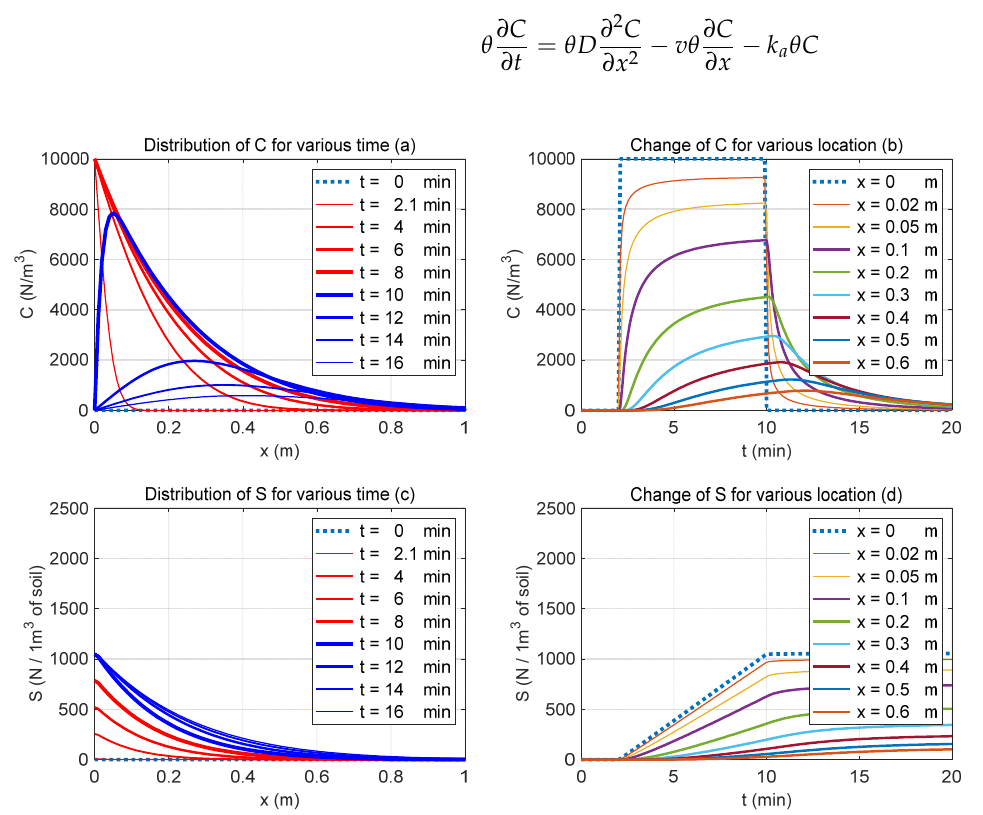
Figure 8. Simulation results for case S5 ( ρ = 2 ρ 0 ): ( a ) distribution of C at various times, ( b ) variation in C at various locations, ( c ) distribution of S at various times, and ( d ) variation in S at various locations.